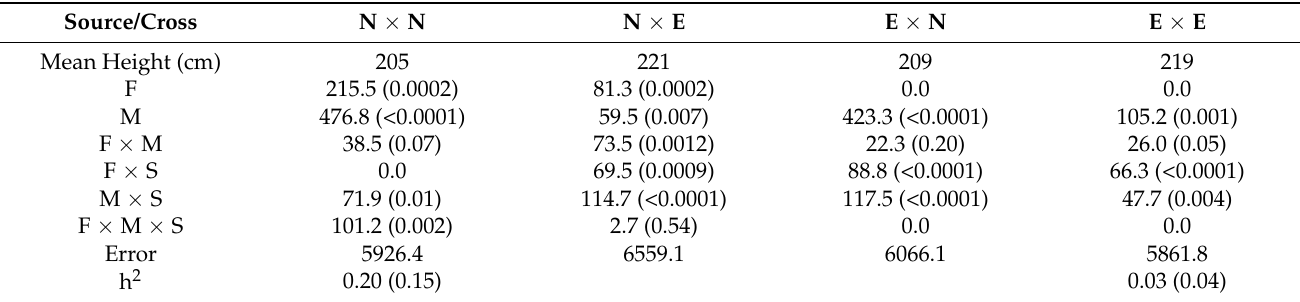
Table 3. Estimates of variance components and narrow sense heritabilities (h 2 ) for height of 100 families after ten or eleven growing seasons at seven sites (sites 1–7) for each crossing type separately. In parentheses, p -values of variance components and standard error of the heritability.